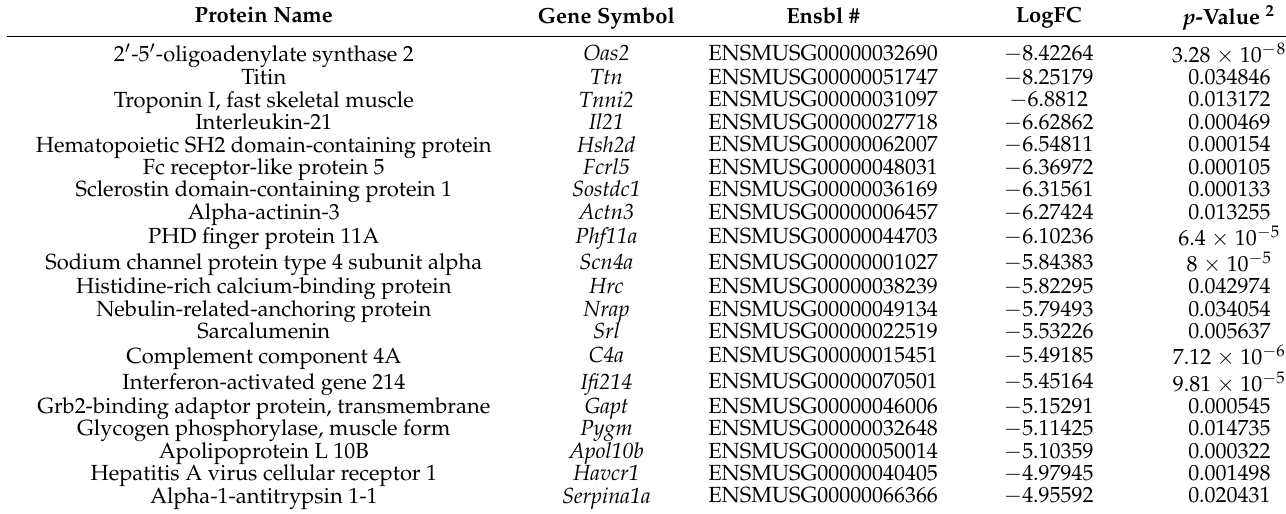
Table 1. Top 20 DE genes upregulated in lacrimal glands of WT mice compared to IFNAR1 KO mice 1 .